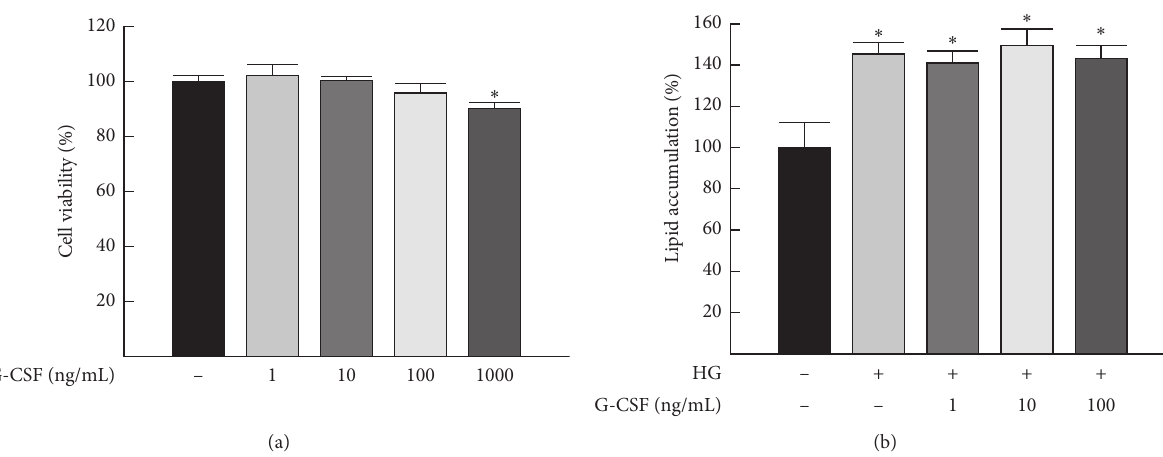
Figure 6: Effect of G-CSF on the viability and high glucose- (HG-) induced lipid accumulation in HepG2 cells . (a) Viability of HepG2 cells after treatment with increasing doses of G-CSF for 36 hours was measured by the MTT assay in triplicate. (b) Lipid accumulation was assessed by quantification of Oil Red O staining in HepG2 cells, which were cultured with either 5.5mM or 45mM HG medium, followed by cotreatment with increasing concentrations of G-CSF for 36 hours. All data are expressed as the means ± standard deviations ( n � 3 per group). ∗ P < 0 . 05 vs. no